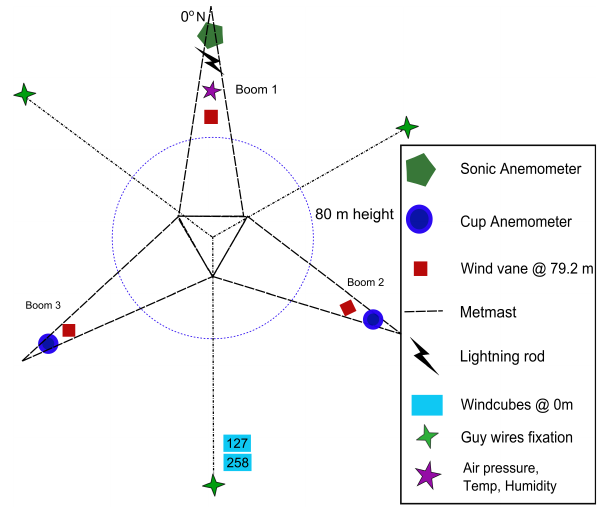
Figure 2. Meteorological mast 3 top view at 80m height. Table 1. Filters used for data